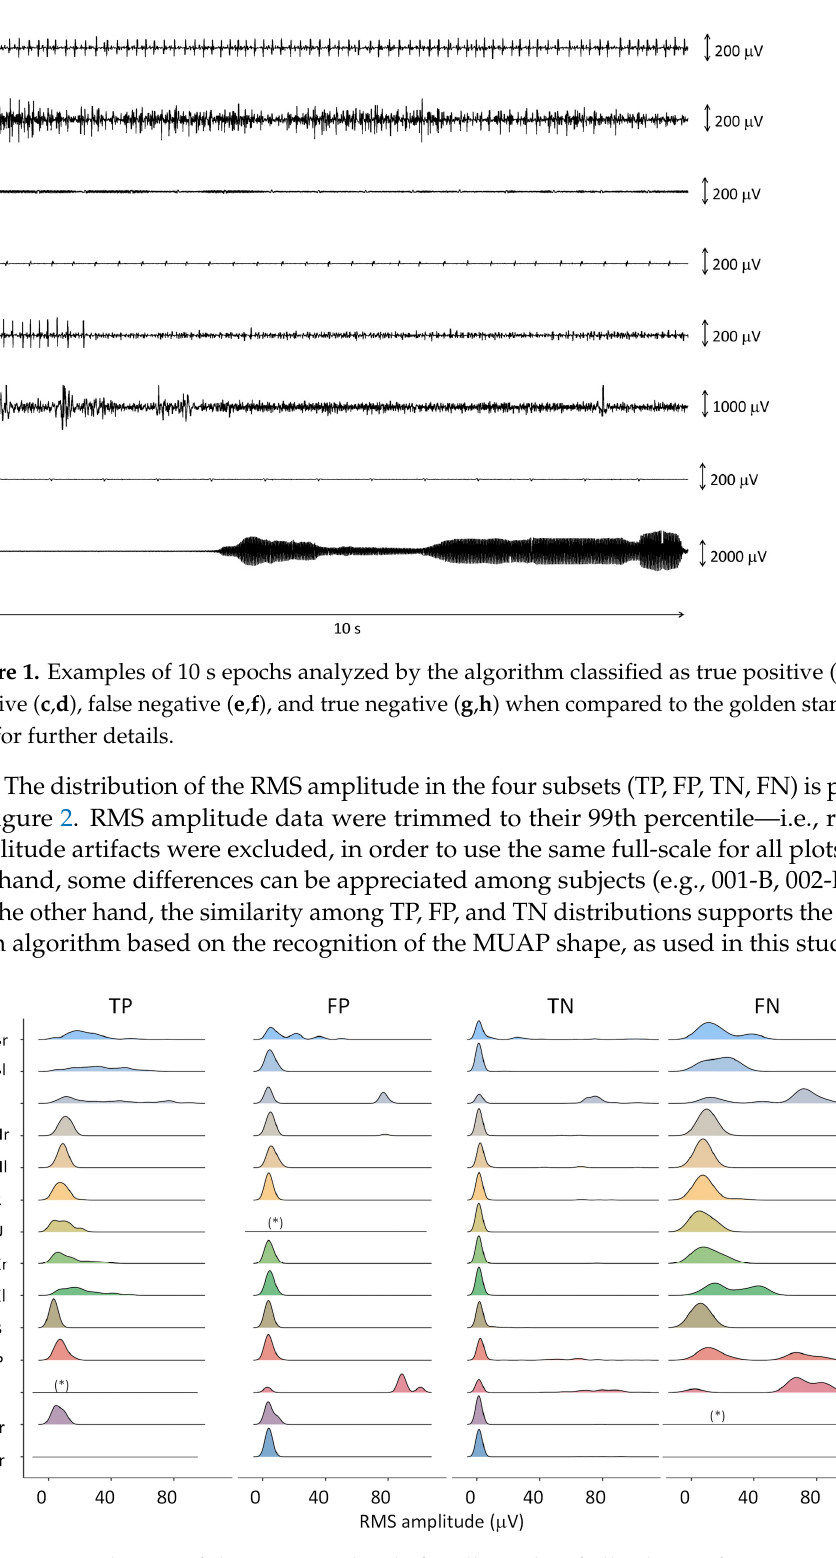
Figure 2. Distribution of the RMS amplitude for all epochs of all subjects, for true positive (TP), false positive (FP), true negative (TN), and false negative (FN) classifications. Legend: (*) less than 3 epochs in this class, distribution not drawn; flat lines: no epochs in this class.